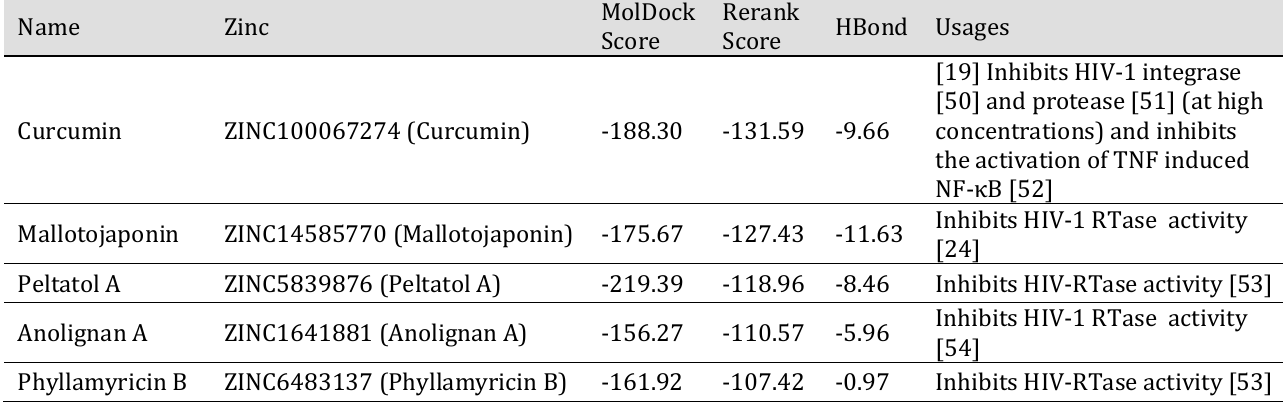
Table 4. The best predicted poses scores among the chosen plant-based compounds with their reported current